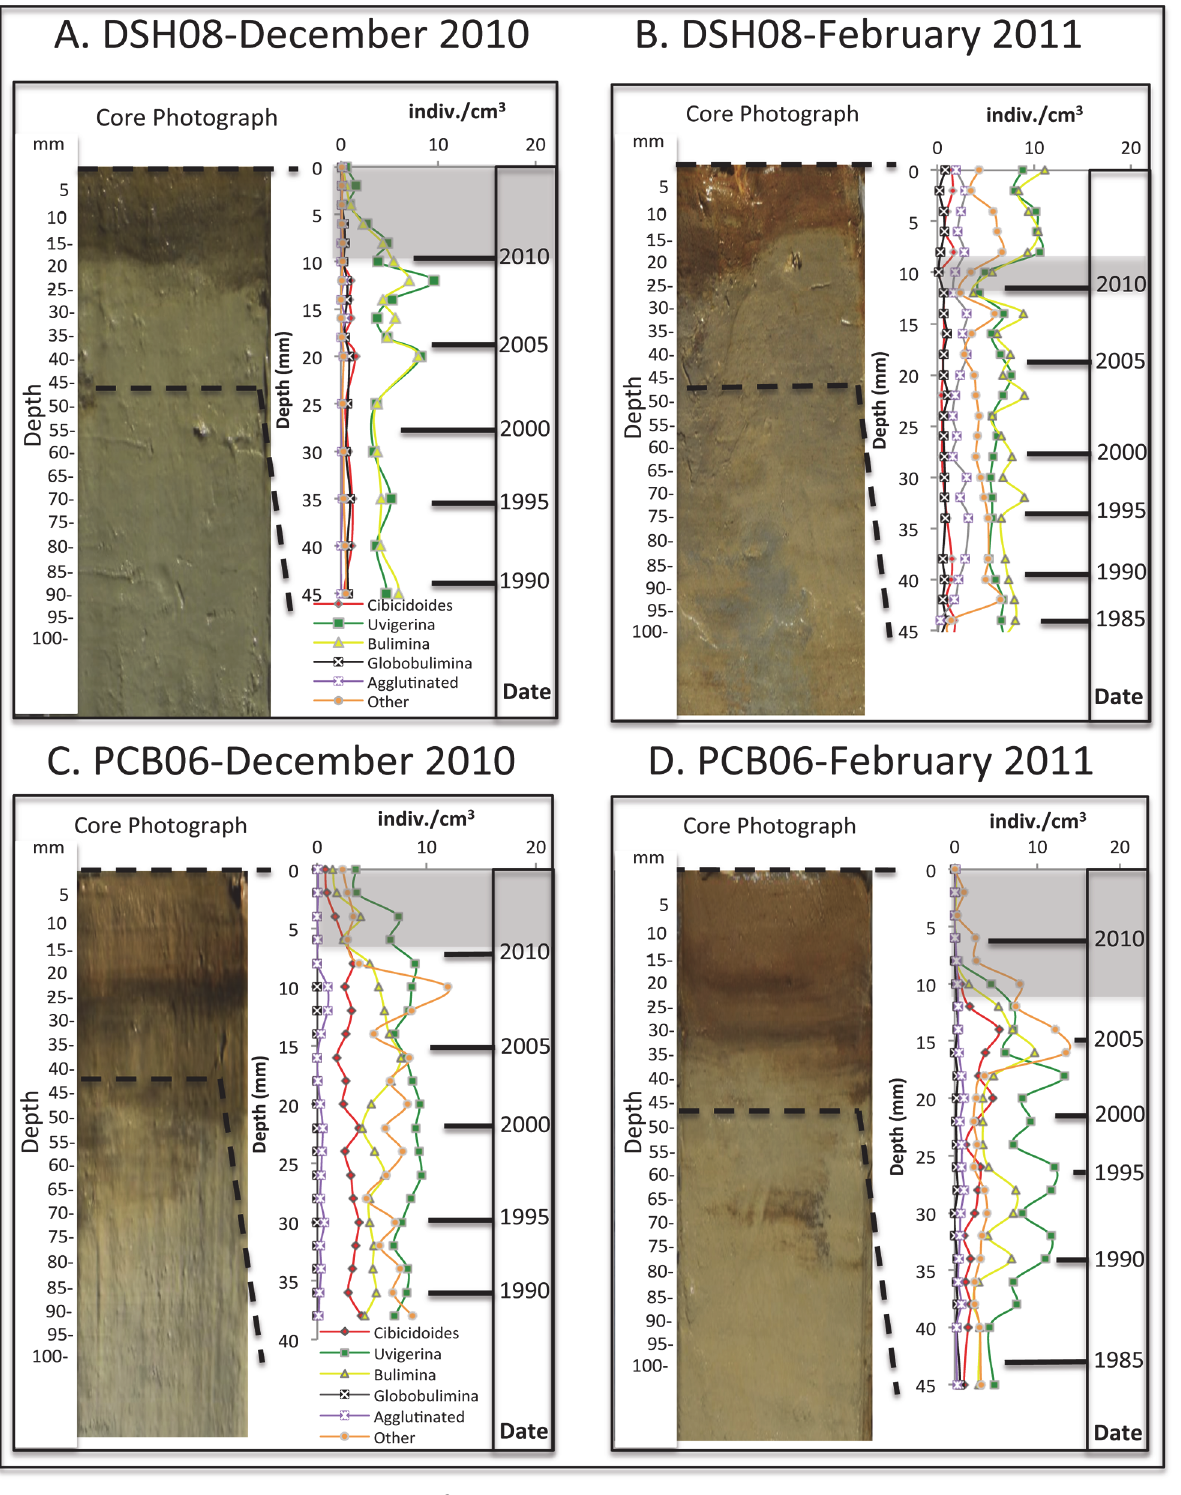
Fig 2. Core photographs and densities (indiv./cm 3 ) of the benthic foraminifera genera throughout the surface sections of each core site including gray areas representing the decline in benthic foraminifera density in each record and the corresponding date.